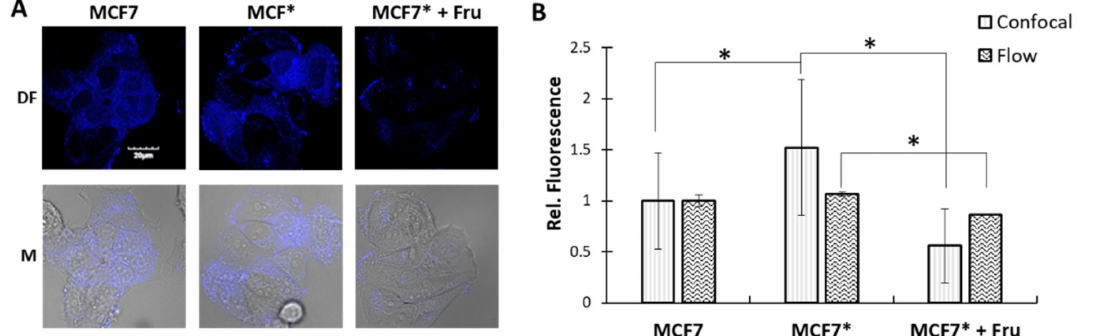
Figure 6. ManCou-F (50 µ M) uptake changes with GLUT5 levels and fructose concentration. MCF7: cells cultured in RPMI-1640 with 10% FBS; MCF7*: MCF7 cells cultured with 11 mM fructose for 25 days. MCF7* + Fru: 11 mM fructose supplemented to the MCF7* culture directly with the probe. ( A ) Images were acquired using 60 × objective and DAPI filter (exc/em: 405 nm/461 nm) at the same laser intensity and exposure time, DF—dark field, and M—fluorescence overlay images with the bright field. Each experiment was carried out in duplicate. ( B ) Data represent fluorescence derived after quantification of fluorescence images using ImageJ as CTCF/Area. Fluorescence obtained by Attune NxT Flow Cytometer using VL1 filter was processed as MF Iprobe (median of fluorescence intensity)-MFI negative (MFI of the cells with no treatment). MFI was derived excluding debris and doublets by FSC-SSC and FSC-H-FSC-W gating, respectively. Error bars represent the relative standard deviation. A two-tailed t -test was used to detect statistically significant differences: * p < 0.05. Relative fluorescence is derived by normalization by the control (MCF7 cells). The scale bar for all images is 20 µ